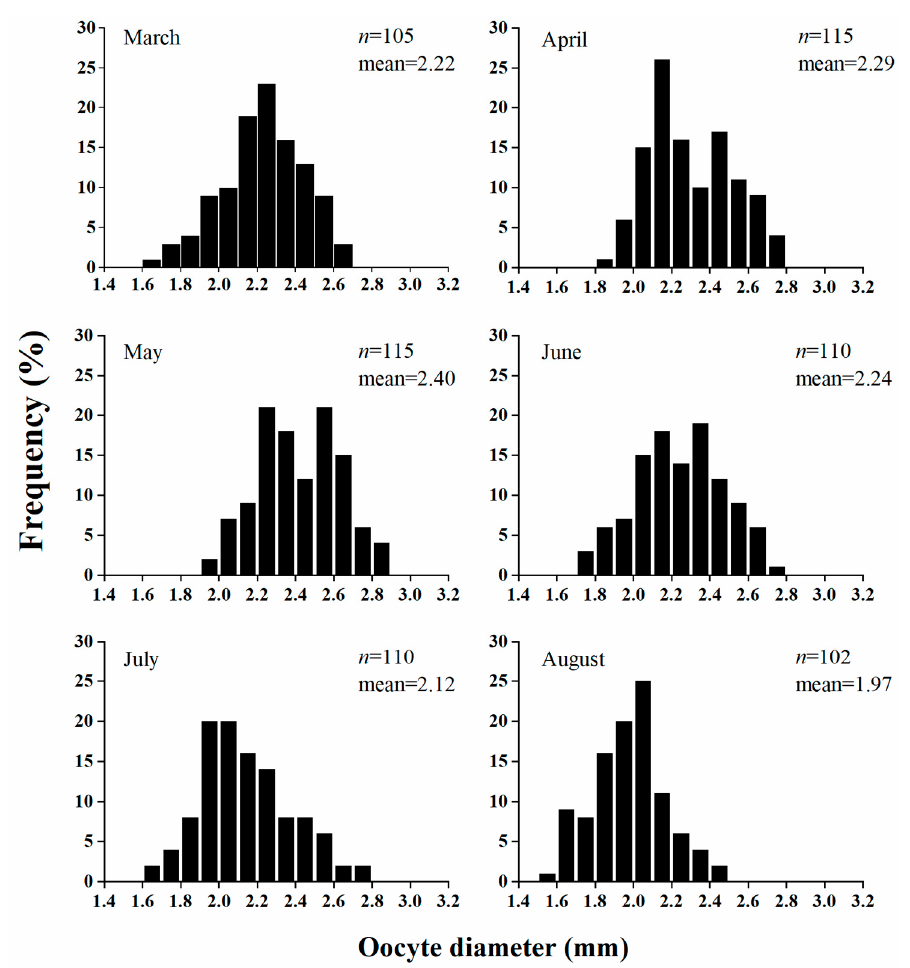
Figure 8. Monthly oocyte diameter distribution in Pseudecheneis sulcatus from March to August 2016. Values in the figure are the number of oocytes measured (n) and the mean diameter of oocytes (mean).